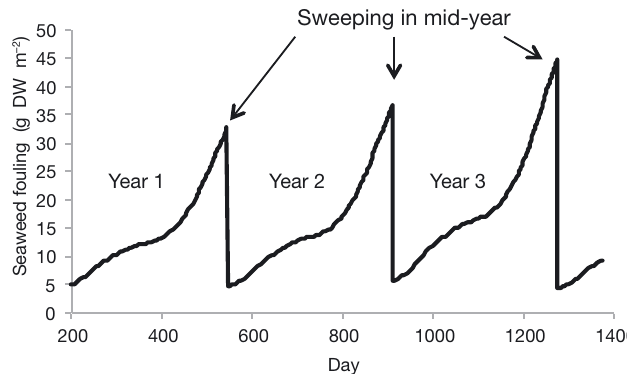
Fig. 9. Seaweed fouling on predator nets at the Chuckanut Shellfish farm; 20 onsite measurements of seaweed dry weight: 90th percentile = 47.4 g dry weight (DW)